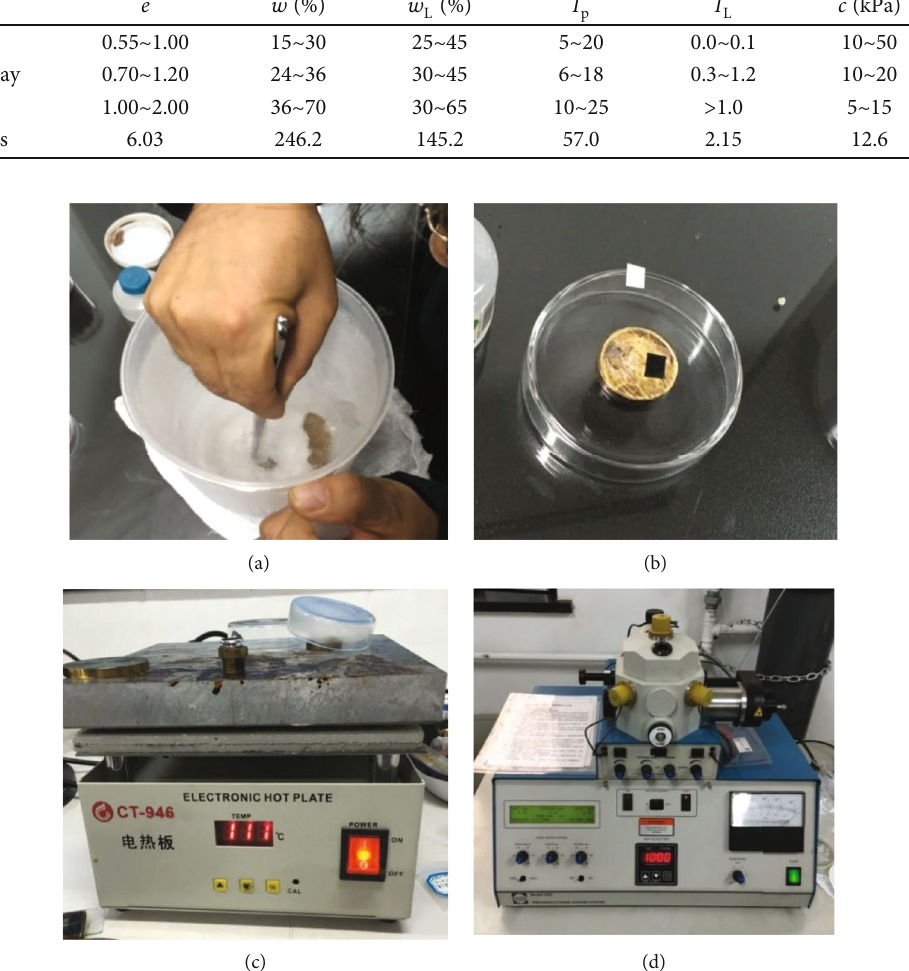
Figure 12: The preparation process of observation soil sample. (a) The deep-sea soil samples were frozen with liquid nitrogen. (b) The undisturbed fresh structural surfaces can be obtained by breaking o ff the freeze-dried samples. (c) The observed fresh sediment samples were moved to the sample table and dried. (d) Carbon was sprayed onto the sediment